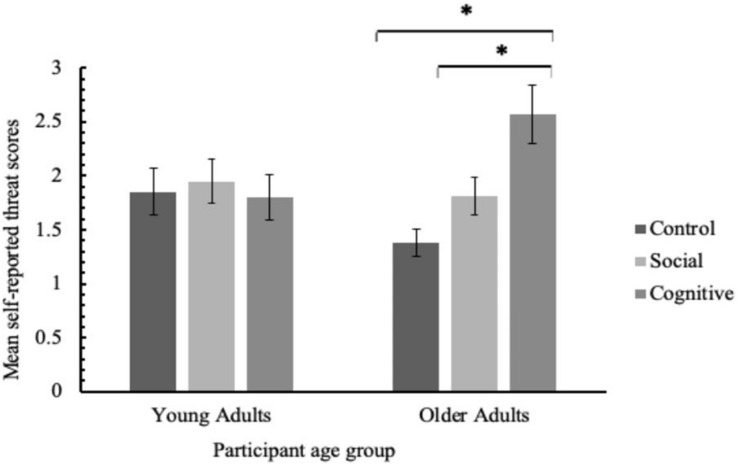
Mean self-reported threat scores as a function of participant age group and stereotype threat condition. Error bars denote one standard error around the mean and asterisks signify a significant difference in mean scores between conditions.